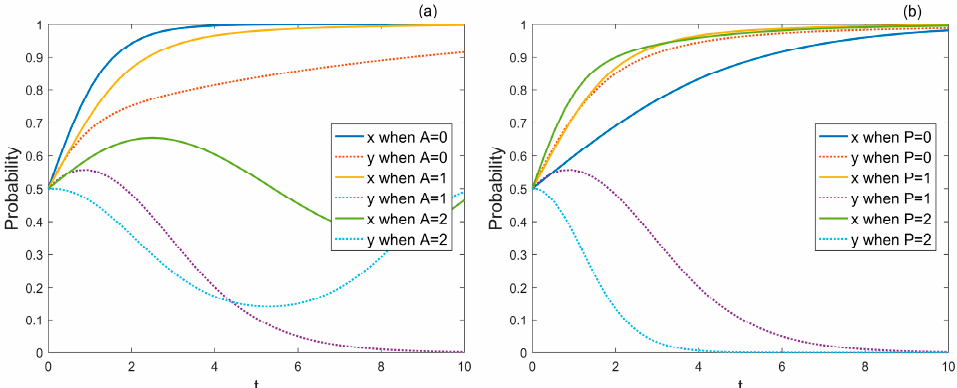
Figure 7. The impact of local government’s incentives ( a ) and penalties ( b ) on the evolutionary